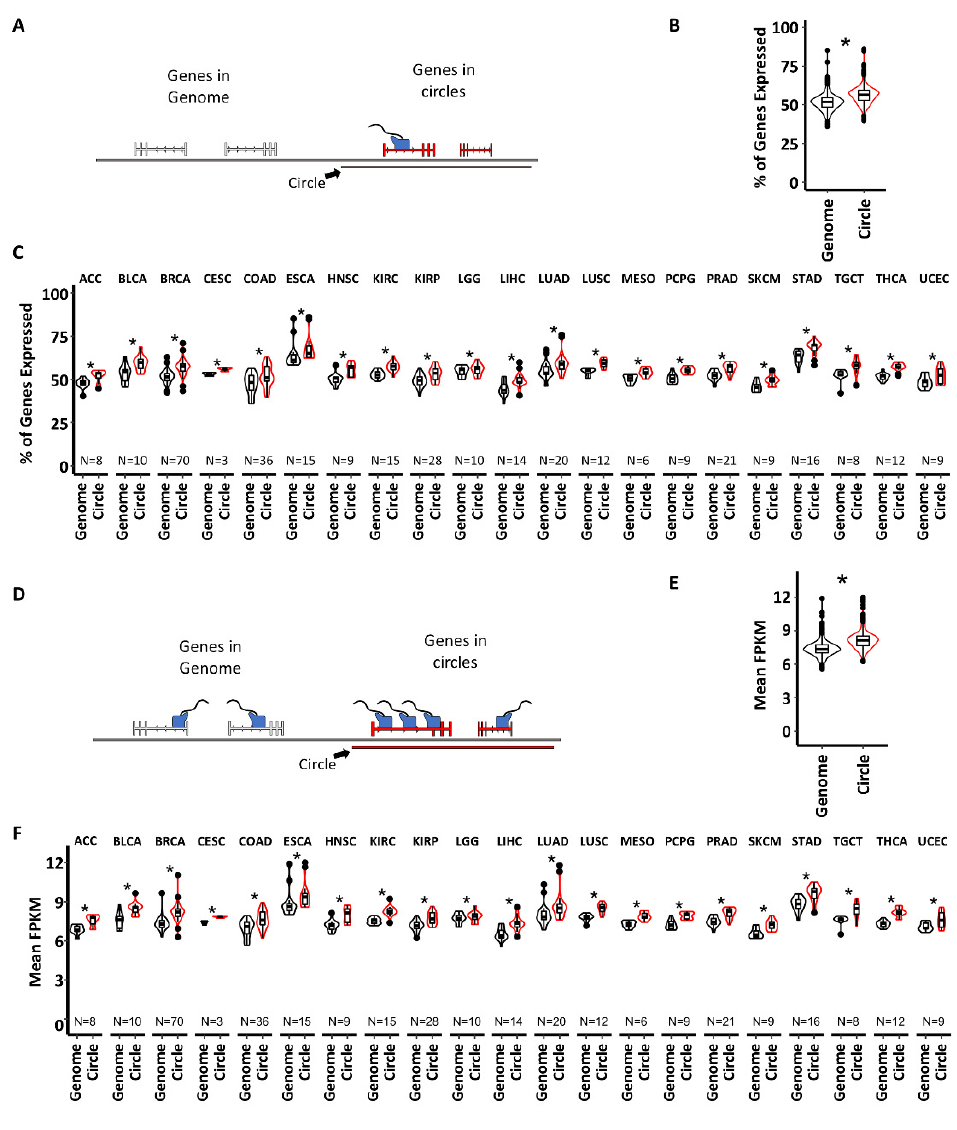
Figure 2. More genes in circles are expressed, and are more highly expressed, than genes located elsewhere in the genome. ( A ) Schematic showing how genes associated with circles were isolated. No genes that crossed a circle breakpoint were considered associated with a circle. ( B ) The pan-cancer distribution of the percent of genes expressed in the genome vs expression of genes associated with circles. ( C ) The distribution of the percentage of genes expressed in the genome vs genes associated with circles for individual cancer types. ( D ) Schematic showing how genes were categorized to determine the expression differences between genomic genes and genes associated with circles. ( E ) Pan-cancer analysis of mean gene expression for expressed genes in the genome vs gene associated circles. ( F ) Individual cancer analysis of mean gene expression for expressed genes in the genome vs genes associated with circles. Significance was determined by two tailed t -test, * indicates a p -value less than